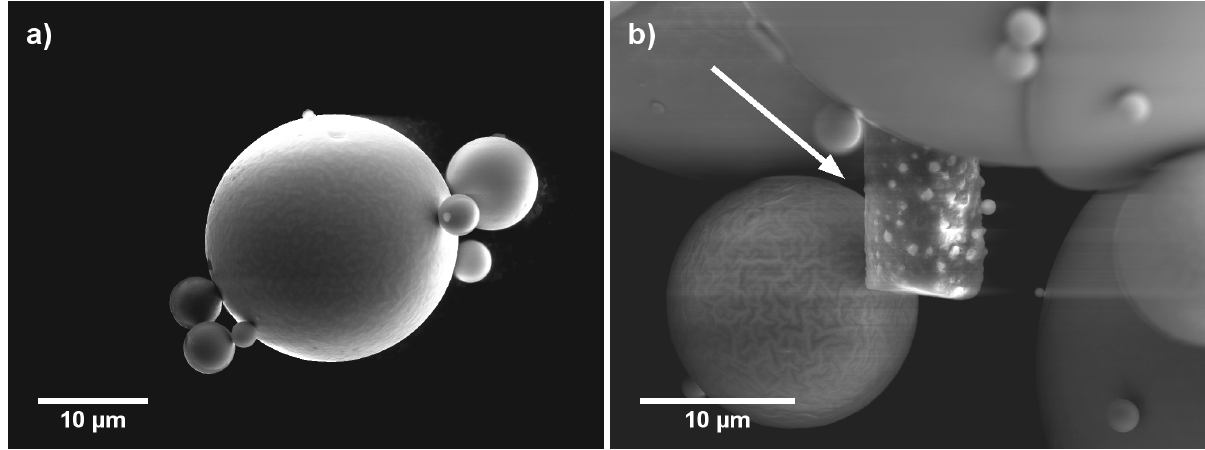
Figure 1. SEM images of the Zr-based metallic glass powder. The average particle size is 25 µm. The spherical shape ( a ) is a result of the production by high pressure gas atomization. Contaminating particle indicated with an arrow in ( b